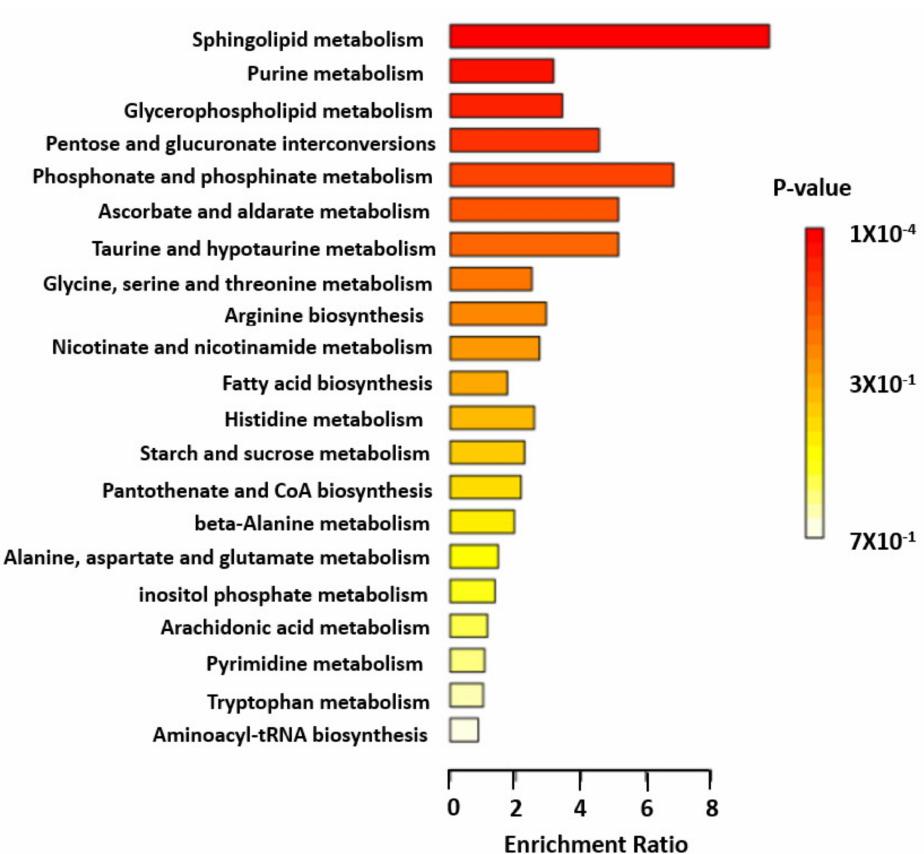
Figure 2. Pathway analysis of validated and clustered metabolite. Enrichment ratio of each top metabolic pathway is shown. Color indicates level of statistical significance, with darker red reflecting smaller p -values and lighter color down to white reflecting larger p